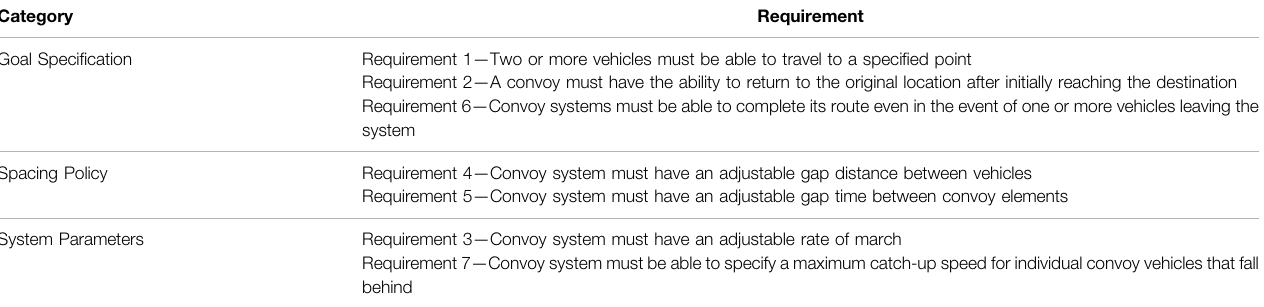
TABLE 2 | Categorized manned convoy requirements. Category Requirement Goal Speci fi cation